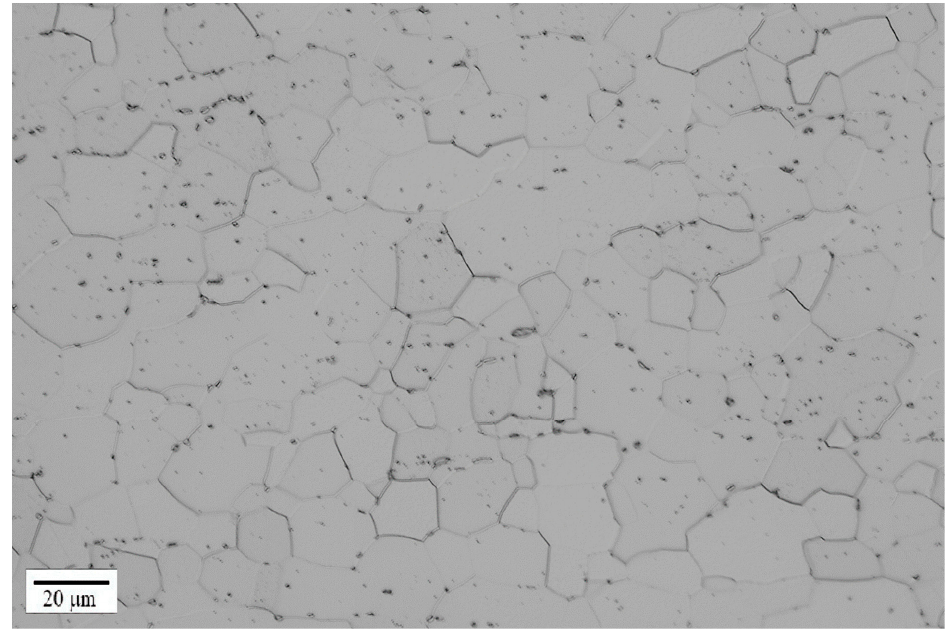
Figure 3. Optical micrograph of the parent metal.